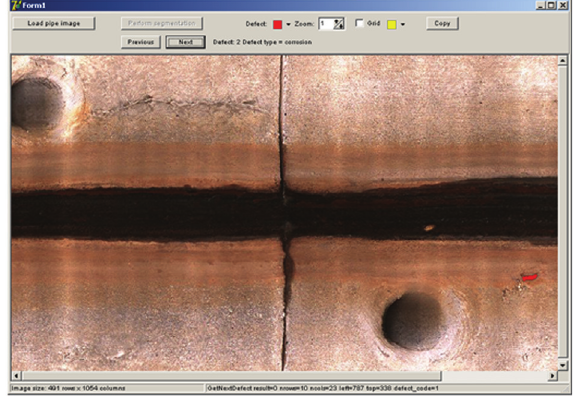
Figure 9: GUI display of corrosion